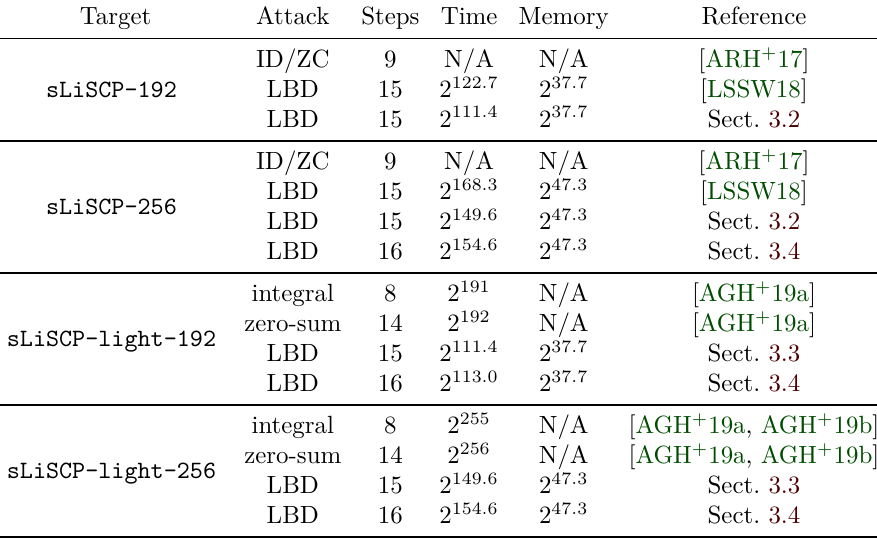
Table 1: Comparison of the Attacks against sLiSCP and sLiSCP-light Target Attack Steps Time Memory